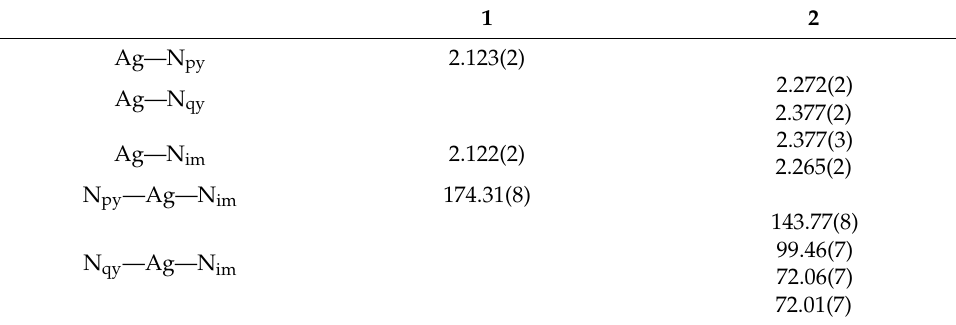
Figure 1. The ORTEP diagrams of complexes 1 and 2 with the thermal ellipsoids drawn at the 50% probability level. The hydrate molecule in 1 including all hydrogen atoms and perchlorate anions in both complexes have been omitted for clarity. Table 1. Selected geometric parameters for complexes 1 and